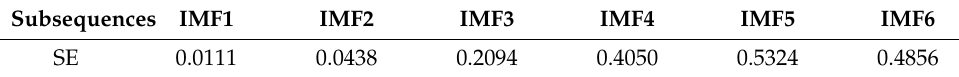
Figure 6. The VMD decomposition of the UP17 measurement point.